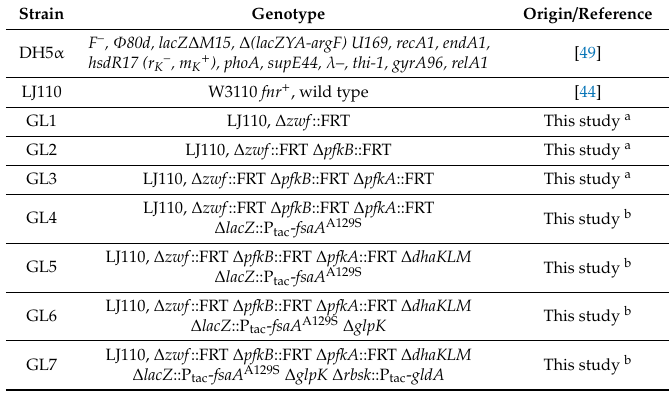
Table 1. List of bacterial strains used in this study. All strains, except DH5 α , are derived from Escherichia coli K-12 W3110 strain (LJ110). Methods employed to create the strains: a Datsenko and Wanner [47] and b CRISPR / Cas